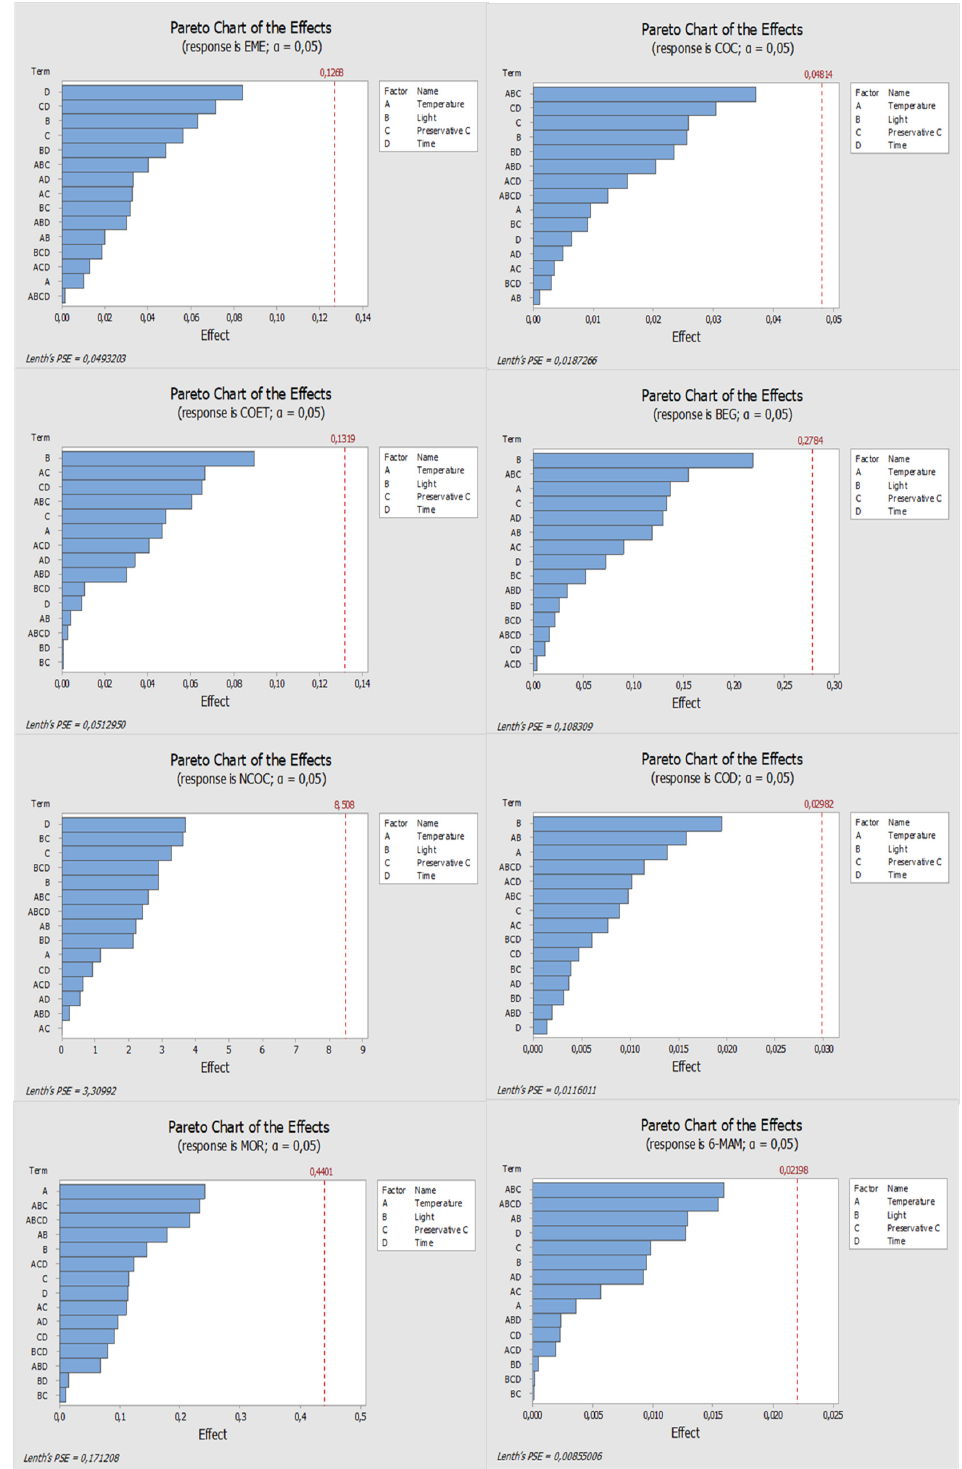
Figure 3. Pareto diagrams of the compounds under study, obtained when sodium fluoride was used as the preservative. The blue bars represent the effects of factors or a combination of factors: A—Temperature, B—Light, C—Preservative, and D—Time.